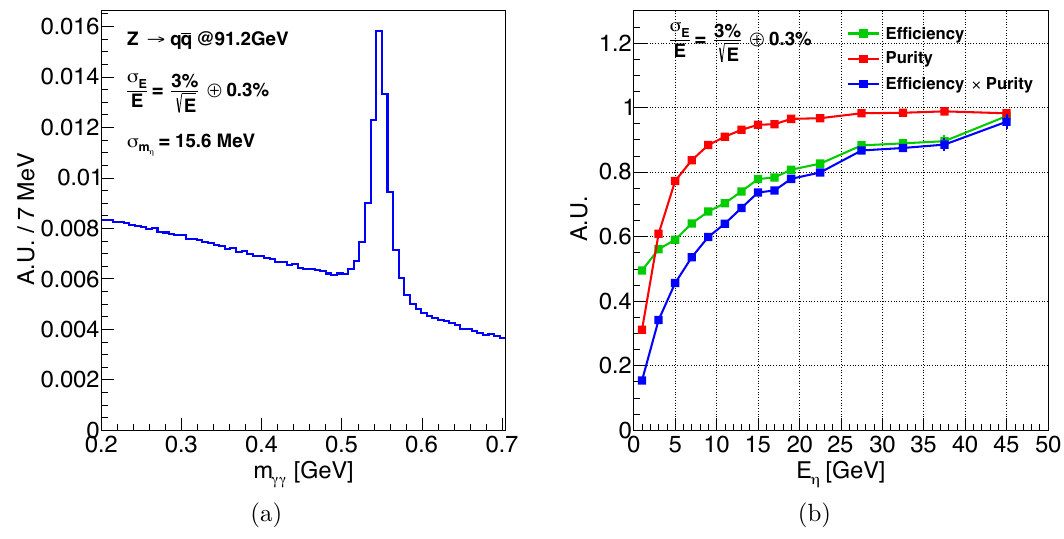
√ Figure 4 . η reconstruction performance of the inclusive Z → q ¯ q ( s = 91.2 GeV) sample when the ECAL energy resolution is 3% √ ⊕ 0 . 3% . (a) Invariant mass spectrum of photon pairs with η E mass peak around 550 MeV and the combinatorial background underneath. (b) Energy differential η reconstruction efficiency and